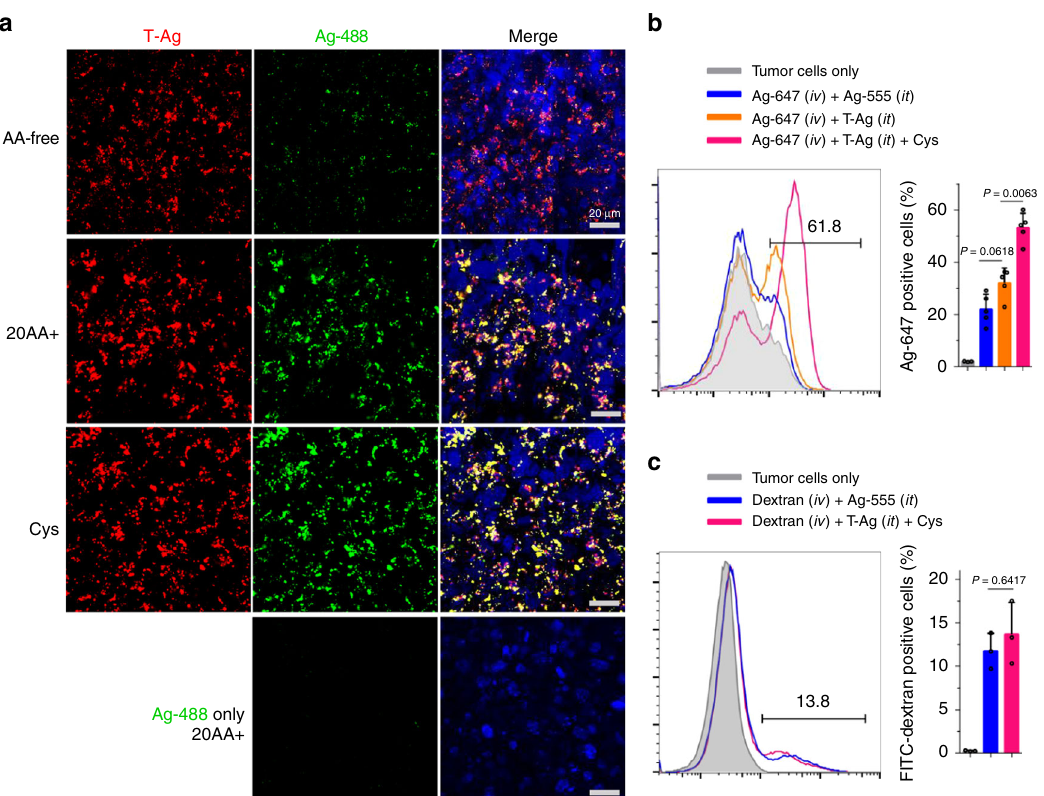
Fig. 6 Demonstration of T-NP-induced bystander uptake under physiological conditions. a Bystander uptake of Ag-488 by live tumor slices. T-Ag and Ag- 488 were incubated with live 4T1 tumor slices in AA-free, 20AA + , and Cys medium for 2 h. After incubation, slices were etched, stained with DAPI (blue) and imaged by confocal microscope ( n = 3 mice for each group). Scale bars are 20 µ m. b , c The bystander uptake of Ag-647 ( b ) or dextran ( c ) in 4T1 tumors. 4T1 tumors bearing mice were received Intratumoral (i.t.) injection of T-Ag (±Cys) prior to the intravenous (i.v.) injection of Ag-647 (±Cys) or FITC-dextran (±Cys). Two hours after circulation, mice were transcardial perfused with PBS, and then tumors were collected and further dissociated to single cells, etched and quanti fi ed by fl ow cytometry. The amount of Ag-647 or FITC-dextran positive cells in percentage was shown. Data are represented as the mean ± s.d. of at least three mice for each group ( b n = 3 for control and n = 5 for experimental groups; n = 3 for c ). Quanti fi ed data b , c were analyzed using one-way ANOVA with Tukey ’ s multiple comparisons test. One-way ANOVA, b , F = 60.141, P < 0.0001; c F = 33.373, P = 0.0100.